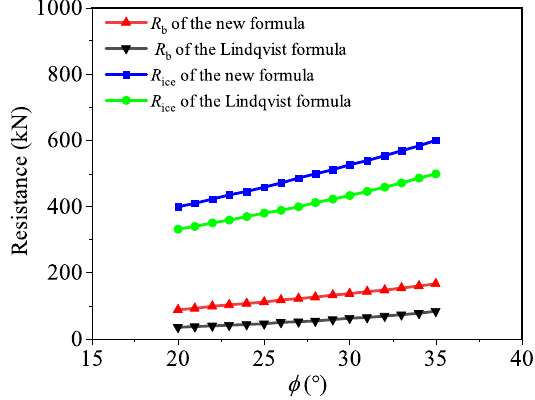
Figure 9. Variation of resistances with the angle of ship bow.